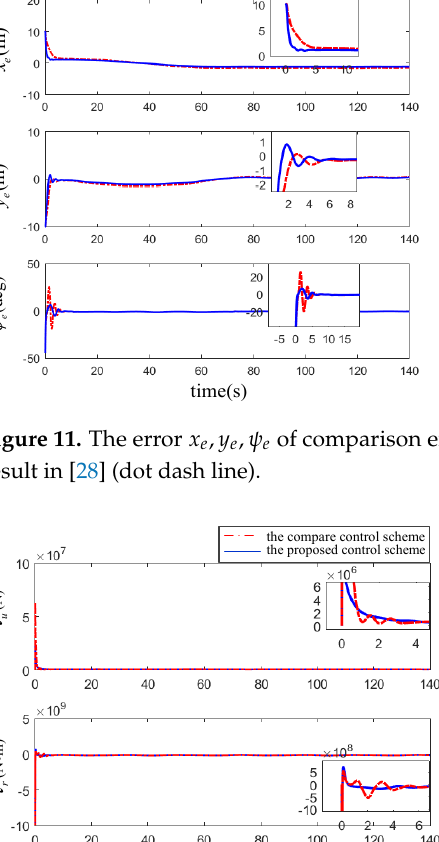
Figure 10. Comparison of the tracking path: the proposed scheme (dot dash line) and the result in [28] (dashed line).